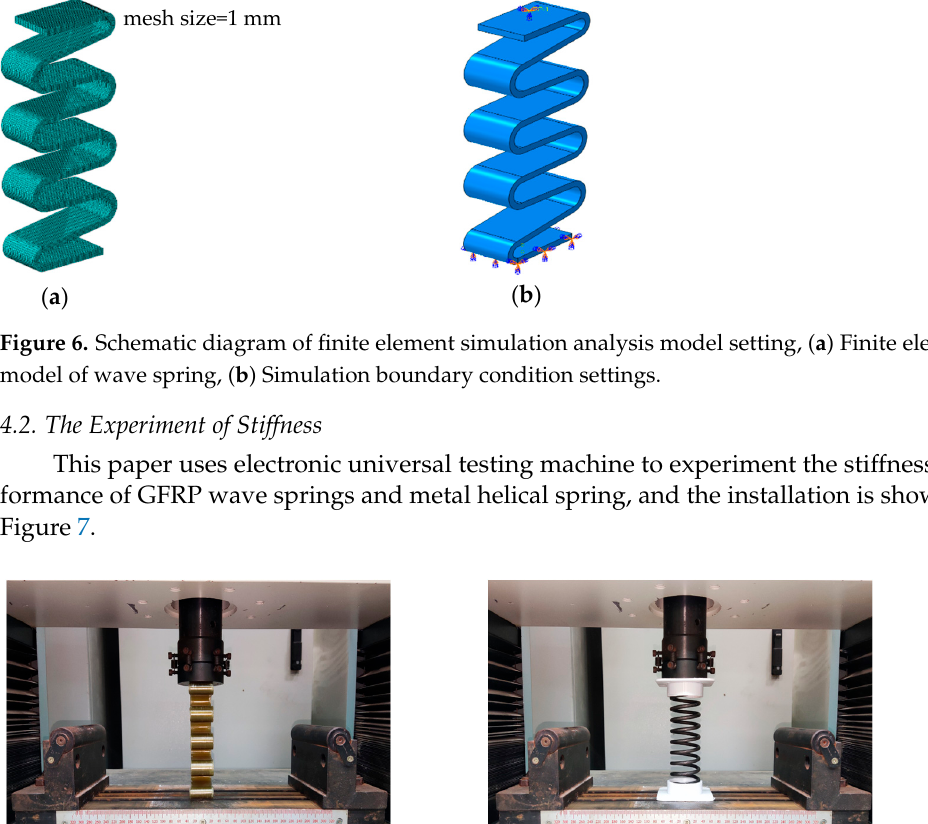
Figure 7. Compression performance experiment bench.